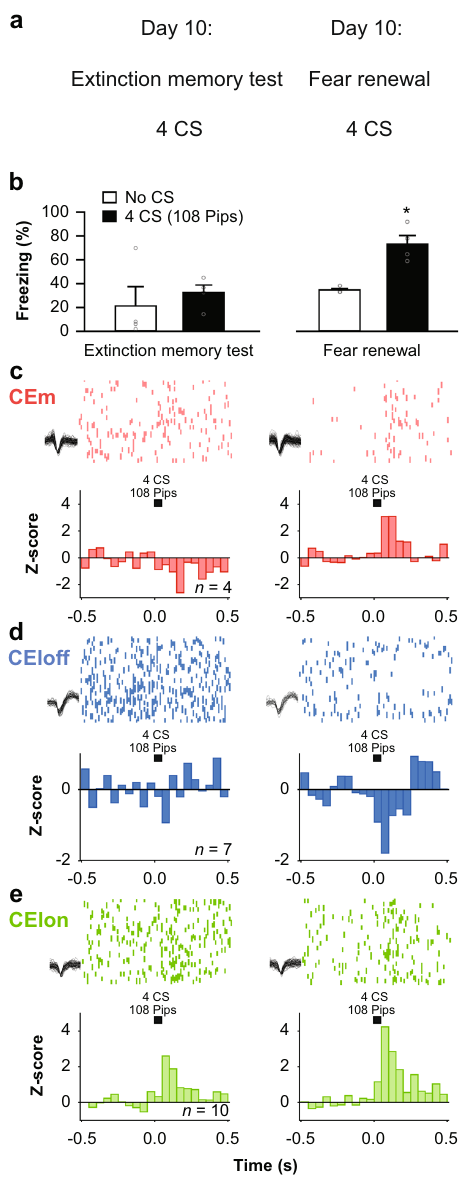
Fig. 3 Context-driven fear renewal reverses extinction-related CEA subpopulation activity. a Behavioural protocol. CS: conditioned stimuli. b Behavioural data. B6 mice: n = 4; extinction memory retrieval, no CS: 21.4± 16.2%, CS: 32.5±6.4%, fear renewal, no CS: 34.8±1.2%, CS: 73.0±7.3%, blocks of 4 CSs. One-way repeated-measures ANOVA F (3,9) = 8.5, p = 0.005 followed by post hoc Bonferroni t -test vs. CS block during extinction memory, p = 0.015. Bar plots are expressed as means±SEM. Circles are freezing values of individual mice. c Raster plots and corresponding spike waveforms of a representative CEm unit (top). Normalized and averaged population peri- stimulus time histograms (bottom). CEm neurons: n = 4 units from 1 mouse; z -score, extinction memory retrieval: − 0.79±1.59, fear renewal: 3.08±1.06, blocks of 4 CSs. Paired student t- test, two-sided, p = 0.039. d Raster plots and corresponding spike waveforms of a representative CEloff unit (top). Normalized and averaged population peri-stimulus time histograms (bottom). CEloff neurons: n = 7 units from 2 mice; z -score, extinction memory retrieval: − 0.04±0.61, fear renewal: − 0.94±0.40, blocks of 4 CSs. Paired student t- test, two-sided, p = 0.041. e Raster plots and corresponding spike waveforms of a representative CElon unit (top). Normalized and averaged population peri-stimulus time histograms (bottom). CElon neurons: n = 10 units from 2 mice; z -score, extinction memory: 1.28±0.41, fear renewal: 2.13±0.37, blocks of 4 CSs. Paired student t- test, two-sided, p = 0.034. All individual neurons of each CEA population had signi fi cant z -score values upon CS presentation (4 CSs during fear renewal). Source data are provided as a Source data fi